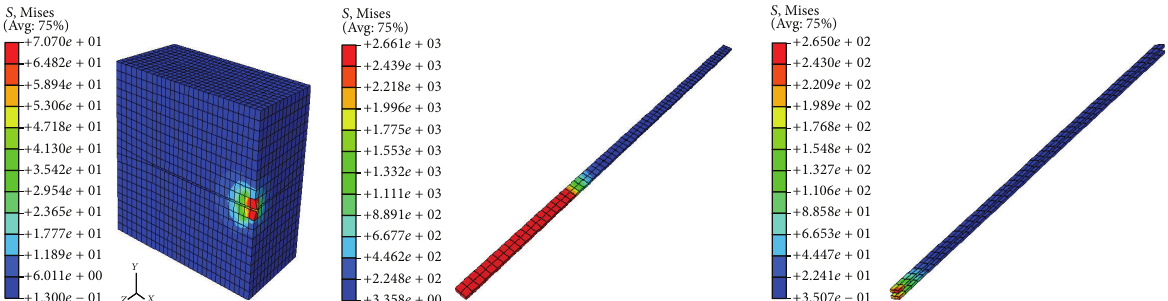
Figure 6: von Mises stress of concrete, FRP plate, and resin layer.